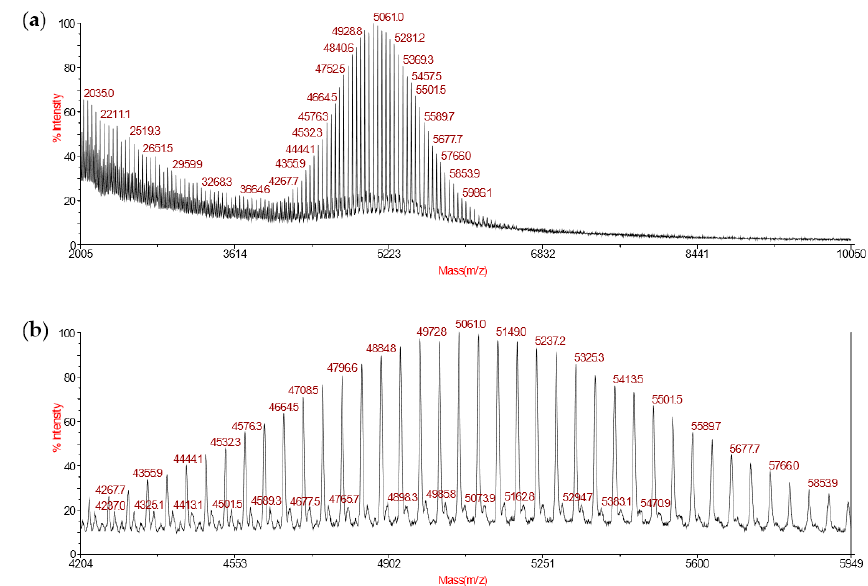
Figure 3. 1 H NMR spectrum of the modified polymer P1 (step 2, CDCl 3 , 25 °C).